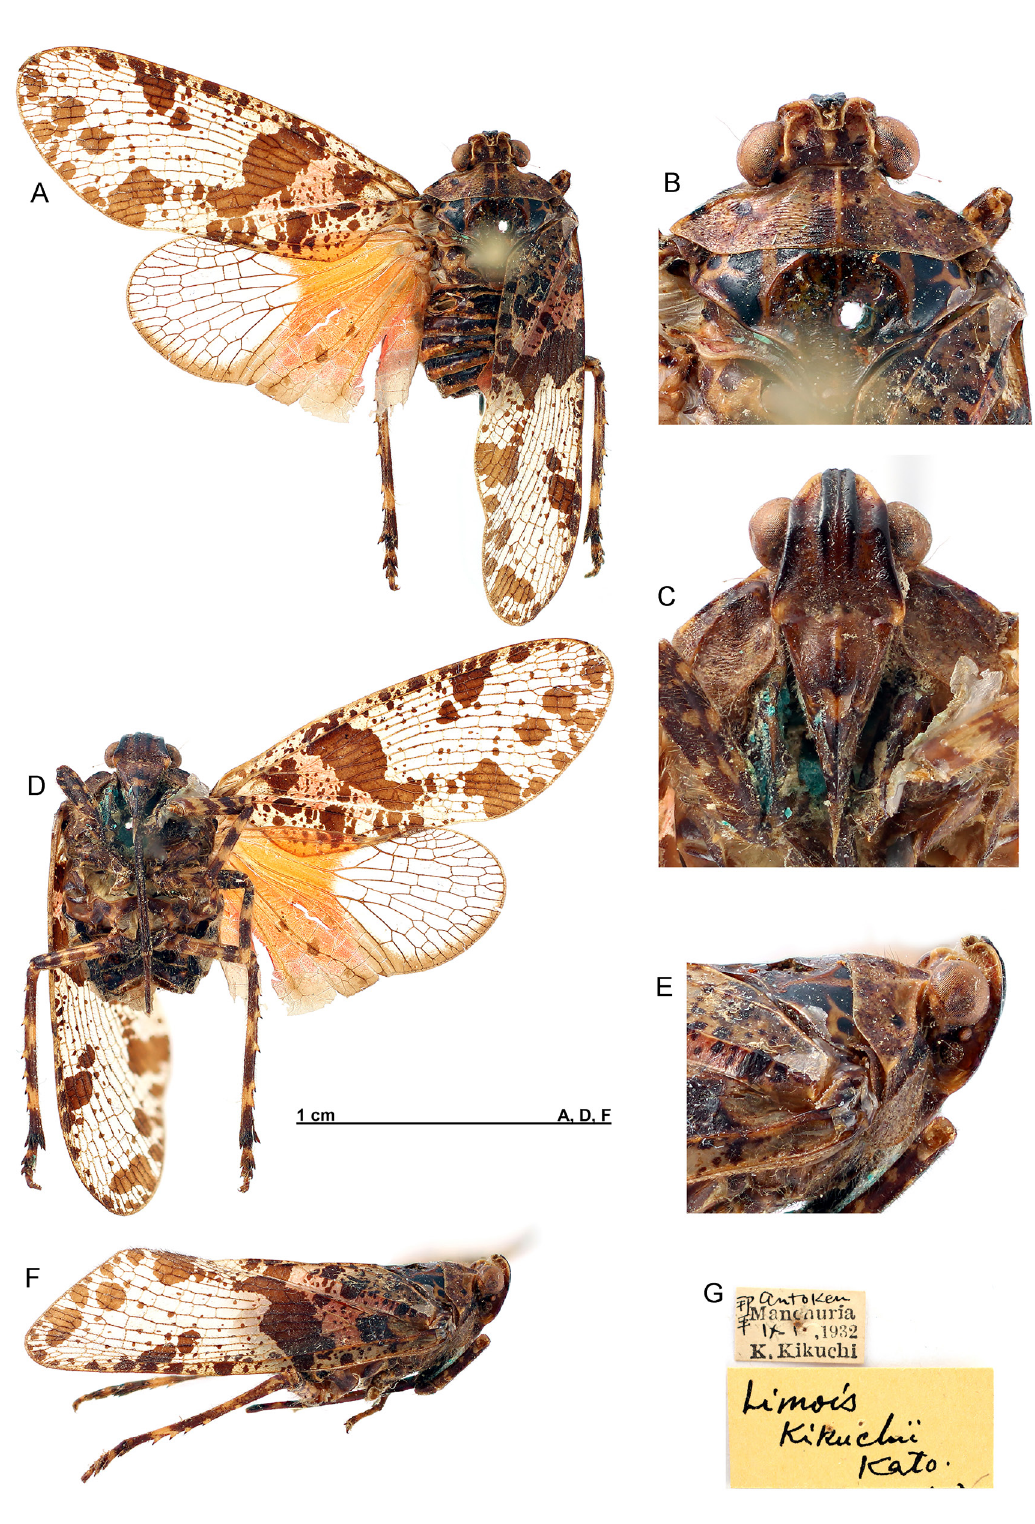
Fig. 4. Limois kikuchii Kato, 1932, Manchuria, K. Kikuchi leg., RBINS, adult male. A . Dorsal view. B . Head and thorax, dorsal view. C . Face. D . Ventral view. E . Head and thorax, right lateral view (showing reflexed protuberance of the vertex). F . Right lateral view. G . Labels. Photographs by J.